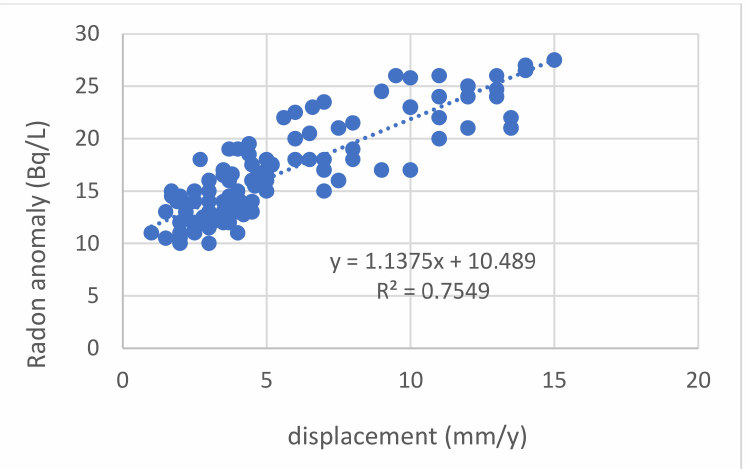
Figure 14. Scattergram for the relationship between the displacement rate and radon gas concentra- tion at the same measurement